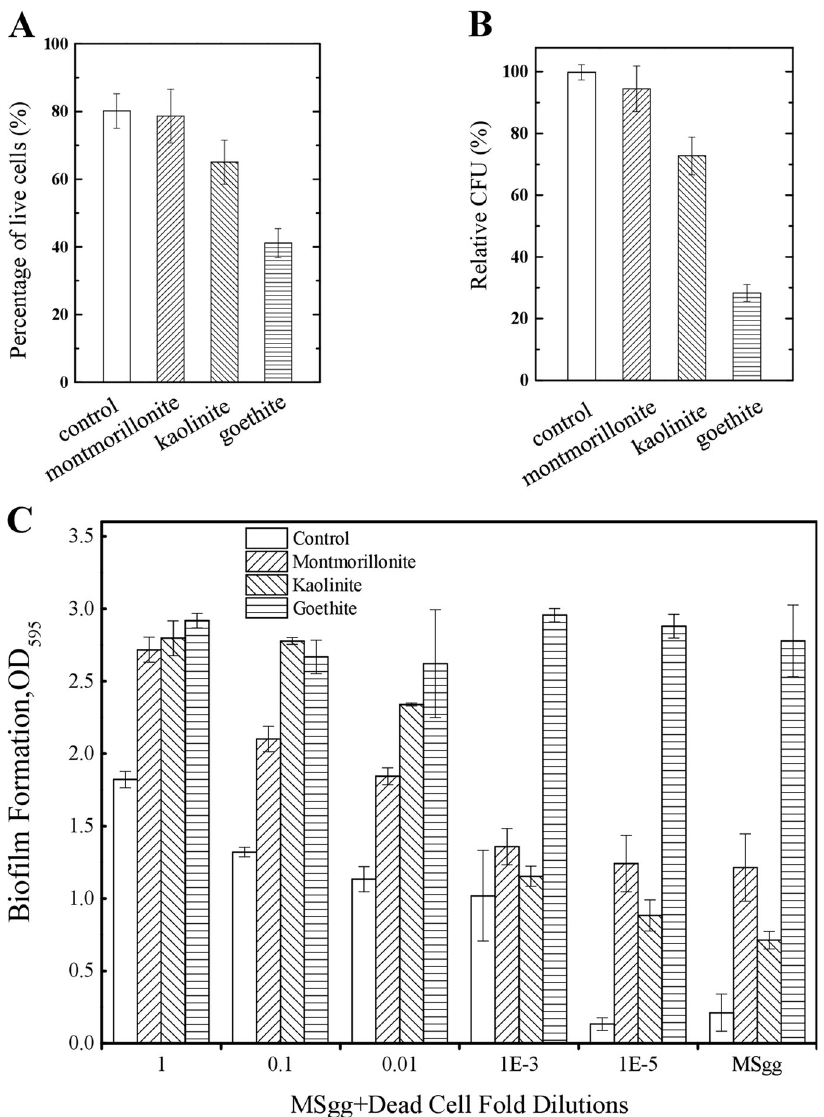
Fig. 3 Mineral-induced lethal effects and their role in bio fi lm formation. a Live/Dead staining assays. Except for the control, cells were exposed to minerals for 24 h and their viabilities were determined and given as percentages. b CFU of control and mineral-exposed cells. CFUs were normalized to the control and showed as relative percentages, respectively. c Effects of different concentrations of dead cells on B. subtilis bio fi lm formation under different